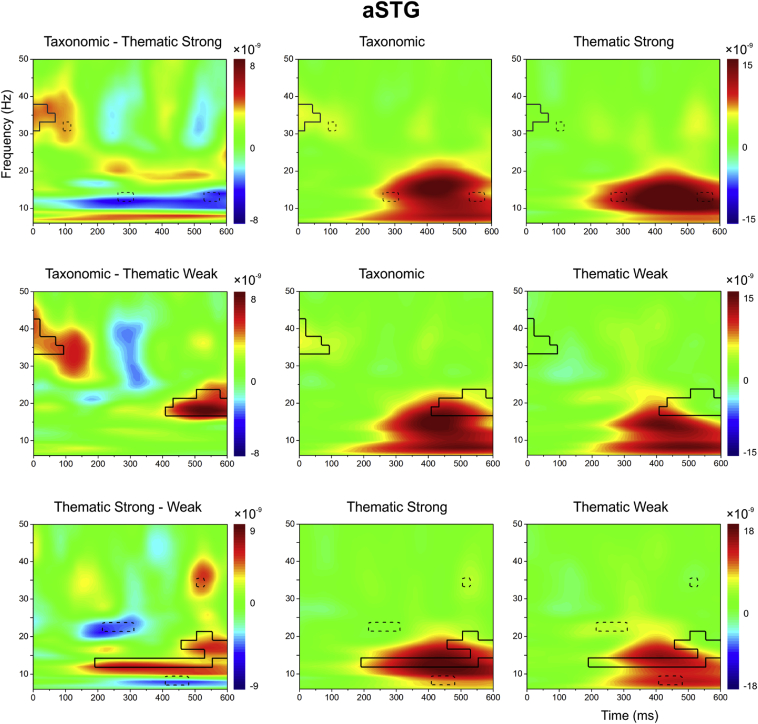
Evoked power in aSTG. Difference plots (left-hand column): Differences between taxonomic and strong thematic trials (TOP ROW), taxonomic and weak thematic trials (MIDDLE ROW) and strong versus weak thematic trials (BOTTOM ROW). The black lines mark statistical contours fulfilling the following criteria: a) the difference between conditions reached p < .05; b) the region was also significantly different from baseline in at least one of the two contributing conditions at p < .01; c) the cluster had six or more contiguous tiles showing a significant difference. The dotted lines show regions which fulfilled the first two criteria but had fewer than six tiles. The plots for each condition (middle and right-hand column) show signal change for each trial type relative to a “passive” baseline.